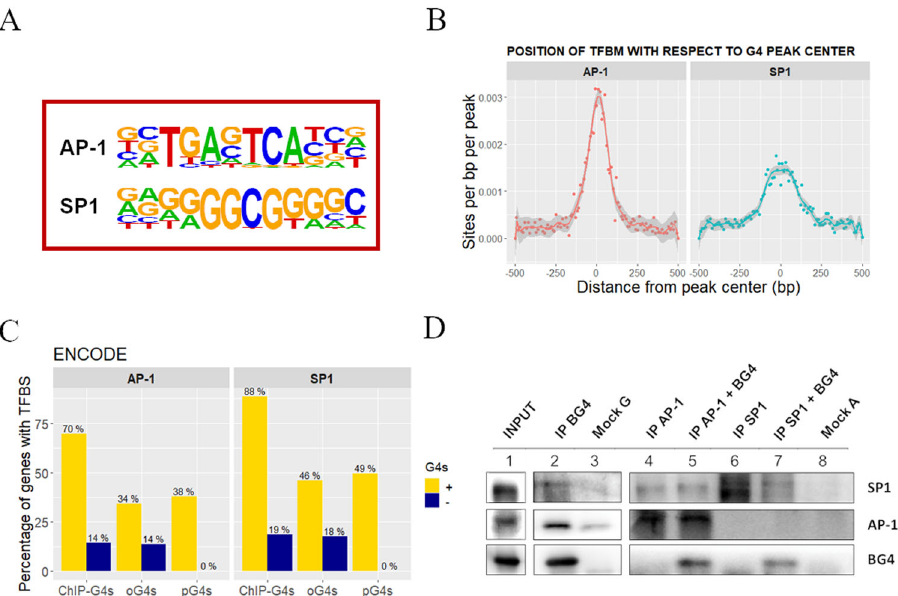
Fig. 5 Identi fi cation of TFs binding to BG4-IP regions in 93T449 cells. A Consensus sequences of TFBSs that are signi fi cantly enriched in BG4 ChIP peaks, as calculated by Homer software. AP-1: p value 1e − 490, SP1: p value 1e − 172. B Position and frequency of TFBSs with respect to the BG4 ChIP peak center. Data points for each TFBS occurrence are reported and fi tted according to a nonparametric spline regression curve, the gray area surrounding the curve represents the con fi dence interval as measure of the regression likelihood. C Percentage of genes with (yellow) and without (darkblue) ChIP-G4s, oG4s, and pG4s containing validated TFBS for AP-1 and SP1, according to ENCODE database. D Western blot showing co-immunoprecipitation of G4s and the two TFs SP1 and AP-1. The INPUT lane 1 corresponds to the total fraction of the sheared chromatin used as starting material. G4s were immunoprecipitated by BG4 antibody (IP BG4), and AP-1 and SP1 were detected by immunoblotting (lane 2). AP-1 (lanes 4 and 5) and SP1 (lanes 6 and 7) TFs were immunoprecipitated from the sheared chromatin with or without previous incubation in the presence of BG4 antibody. Mock G (lane 3) and A (lane 8) are the negative controls immunoprecipitated in the absence of primary antibody using protein-G- or protein-A-coated beads, respectively. The shown blots belong to one of at least two independent biological replicates performed for each sample. Source data for each panel are provided or referenced in the Source data fi